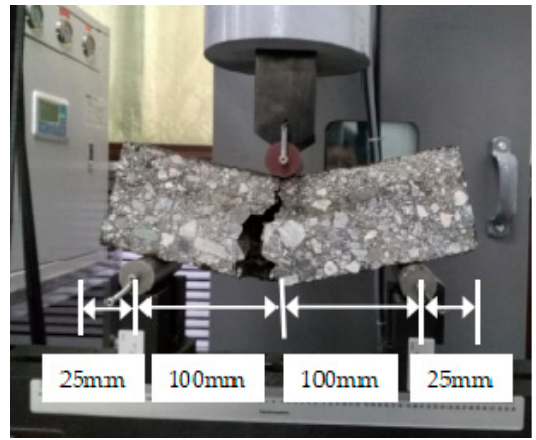
Figure 3. The setup for flexural tensile strength test.